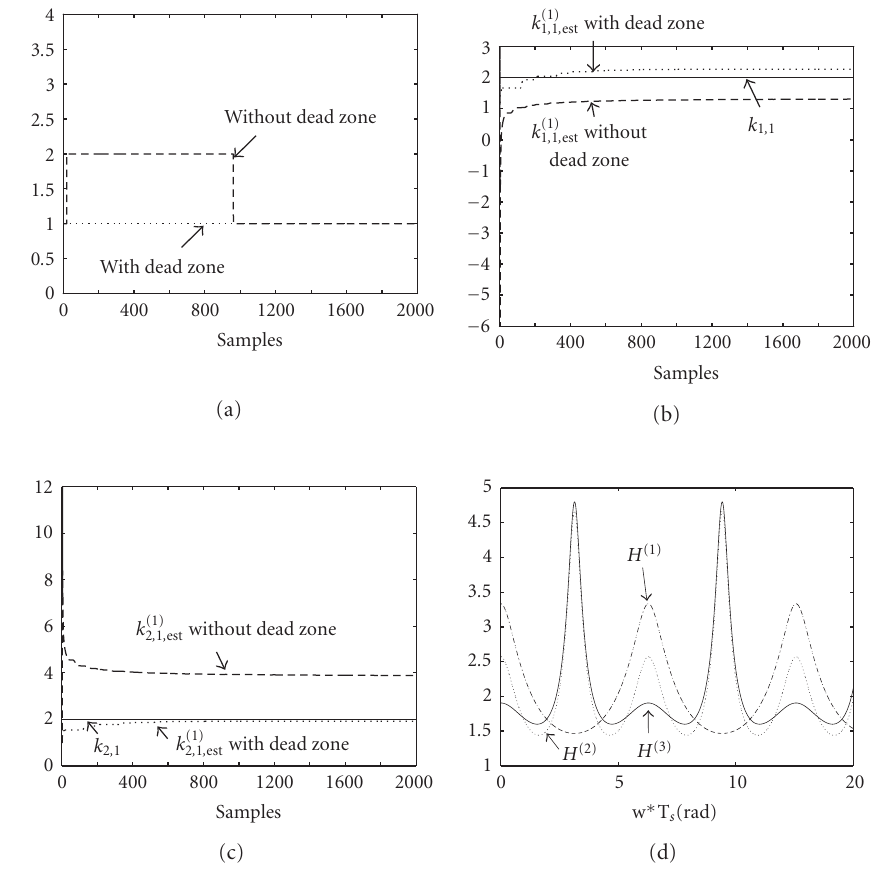
Figure 5.1. (a) Active reduced-order estimation model. (b) Identification of the parameter k (1) 1,1 . (c) Identification of the parameter k (1) 2,1 . (d) Amplitude Bode diagram of the three nominal estimation